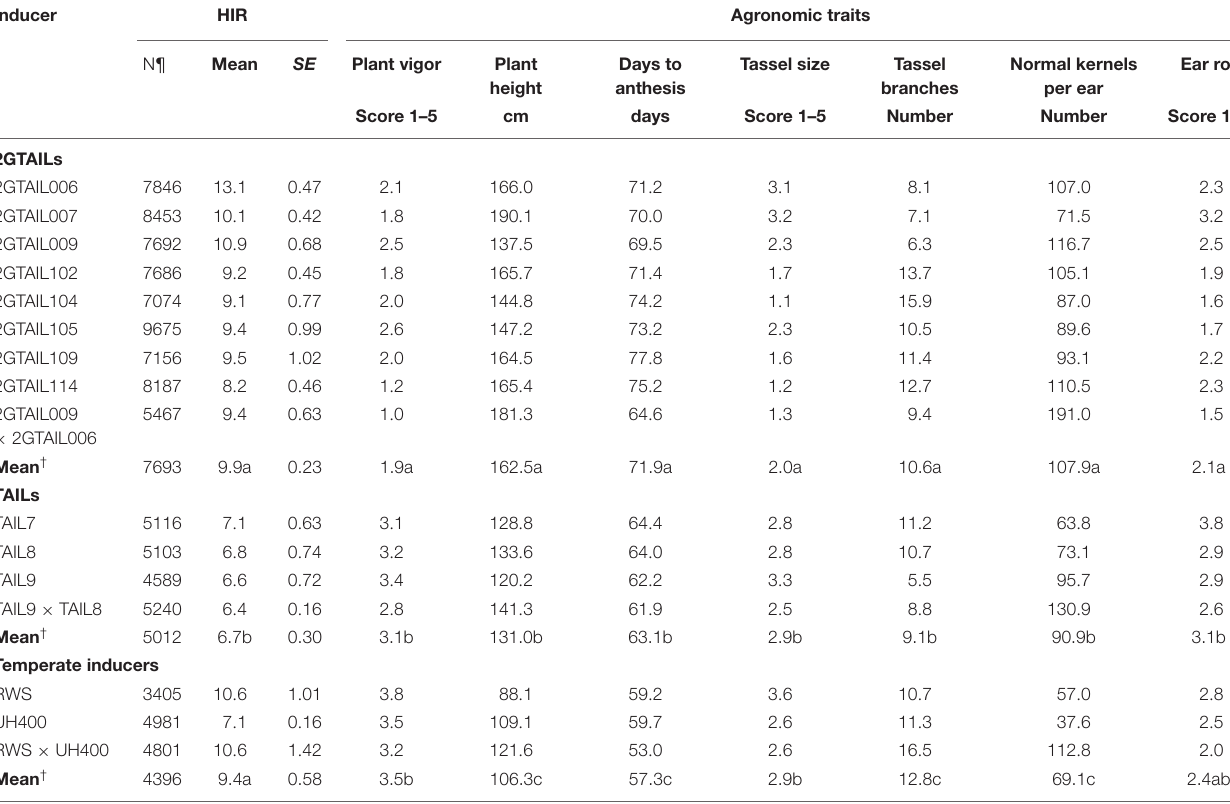
TABLE 4 | HIR and agronomic performance of 2GTAILs in comparison to TAILs and temperate inducers. Inducer